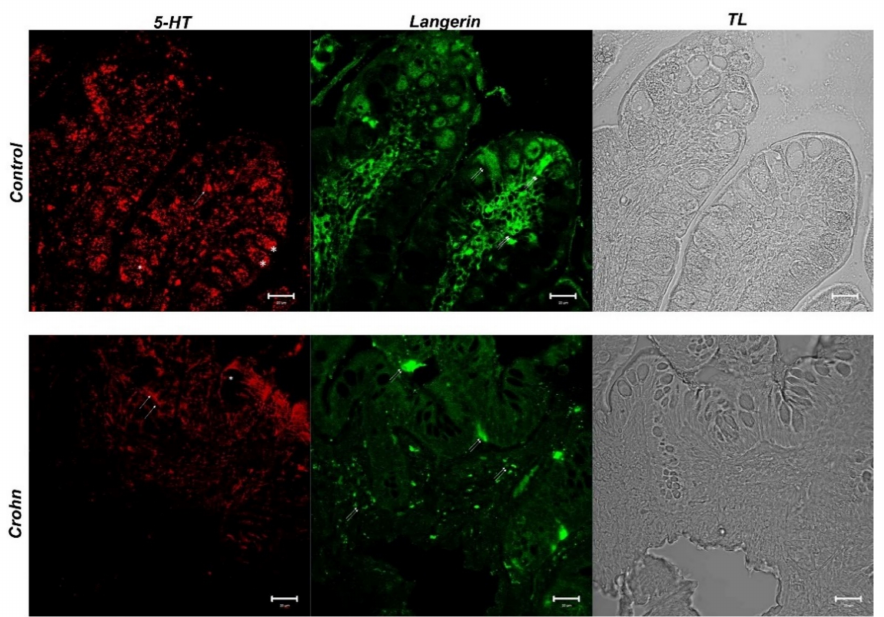
Figure 4. Human intestine. 5-HT and Langerin/CD207, 20 × , scale bar 20 nm. In healthy intestine sections, ECs that were serotonin positive between epithelial cells (arrow) were highlighted with red fluorescence. 5-HT positivity was observed in the goblet cell cytoplasm (*). DCs that were Langerin positive (green fluorescence) were shown in the thickness of the epithelium and the lamina propria (double arrow). In CD samples, 5-HT positivity in goblet cells disappeared and it was more evident in stromal cells (arrows). DCs in the epithelium and lamina propria (double arrows) were marked with Langerin in green fluorescence. The micrographs are also equipped with transmitted light (TL) to visualize the organ morphology.